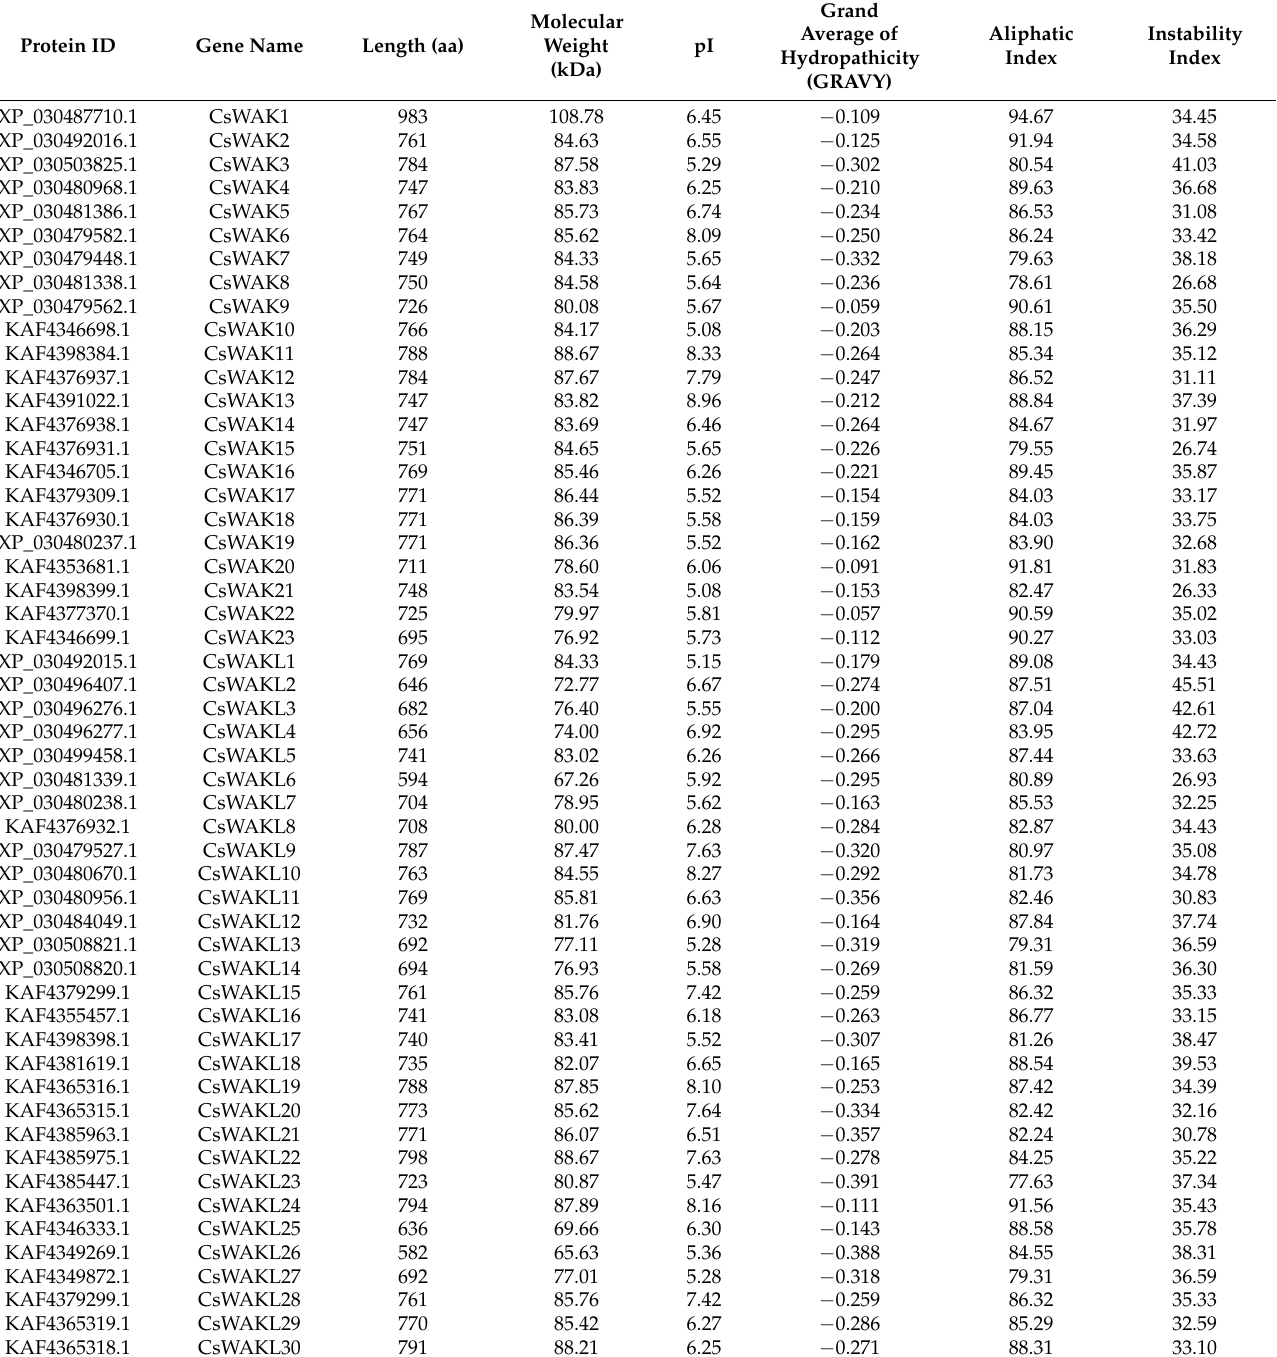
Table 1. The characteristics of 53 CsWAK/CsWAKL proteins in Cannabis sativa